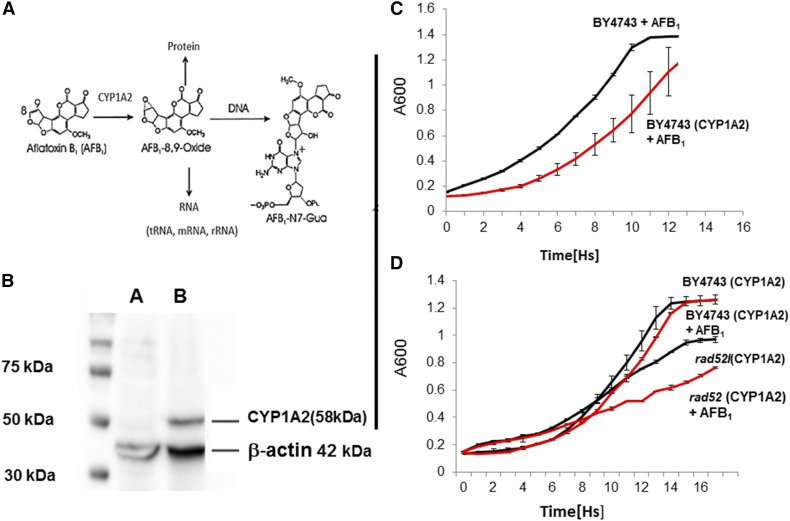
Expression of CYP1A2 in the yeast diploid strain (BY4743). Top left (A) indicates CYP1A2-mediated activation of AFB1 to form a highly reactive epoxide that forms DNA, RNA, and protein adduct; Figure 1(A) adapted from Smela et al. (2002). The lower left panel (B) is a Western blot indicating 75, 50 and 37 kD molecular weight markers. Lanes A and B are lysates from BY4743 and BY4743 cells expressing CYP1A2 (YB556), respectively. The CYP1A2 (58 kD) protein and the β-actin (42 kD) protein are indicated. Right upper panel (C) is a growth curve of the diploid wild type (BY4743) and YB556 after exposure to 100 μM AFB1. Right lower panel (D) is a growth curve of YB556 and rad52 (CYP1A2, YB665) after exposure to 1% DMSO and 50 μM AFB1. Growth (A600) is plotted against time (Hs). Standard deviations are indicated at 1 h time points. Red lines indicate strains both expressing CYP1A2 and exposed to AFB1.